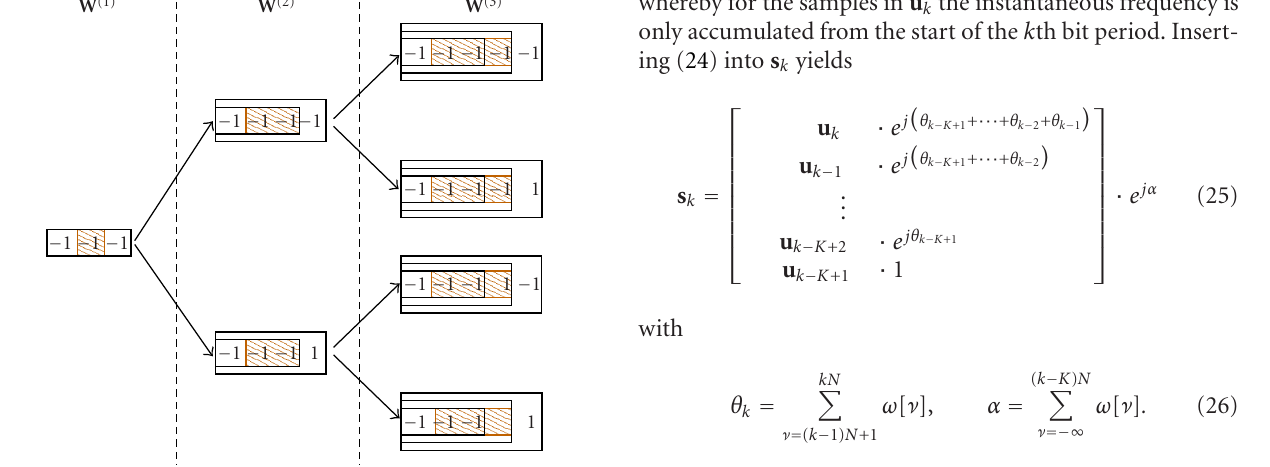
Figure 4: Example for L = 3 of the evolution from the first row of W (1) , representing a sequence of − 1 data pulses, to the first two and four rows of W (2) and W (3)